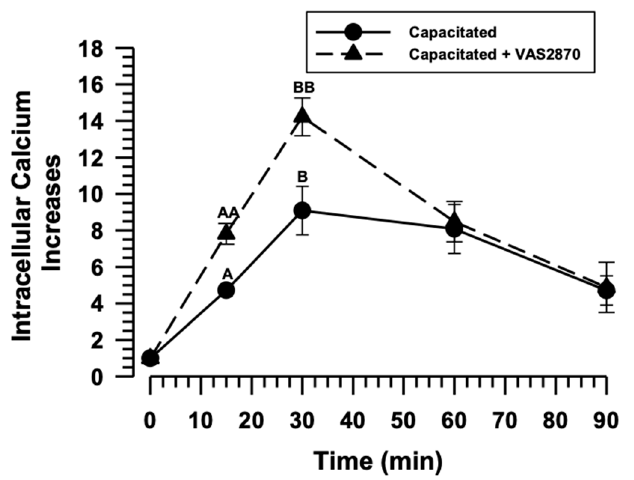
Figure 5. NOX inhibition during capacitation does not affect Ca 2+ influx. The role of NOXs Ca 2+ influx during capacitation was determined in guinea pig spermatozoa. The sperm were incubated under capacitation conditions in the absence and presence of VAS2870 (40 µ M). The [Ca 2+ ]i was recorded at different incubation times by spectrofluorimetry using Fluo-3AM. Results are expressed as the mean ± S.E. ( n = 3). Differences were considered significant when p ≤ 0.05, comparing (A or B) concerning (AA or BB).